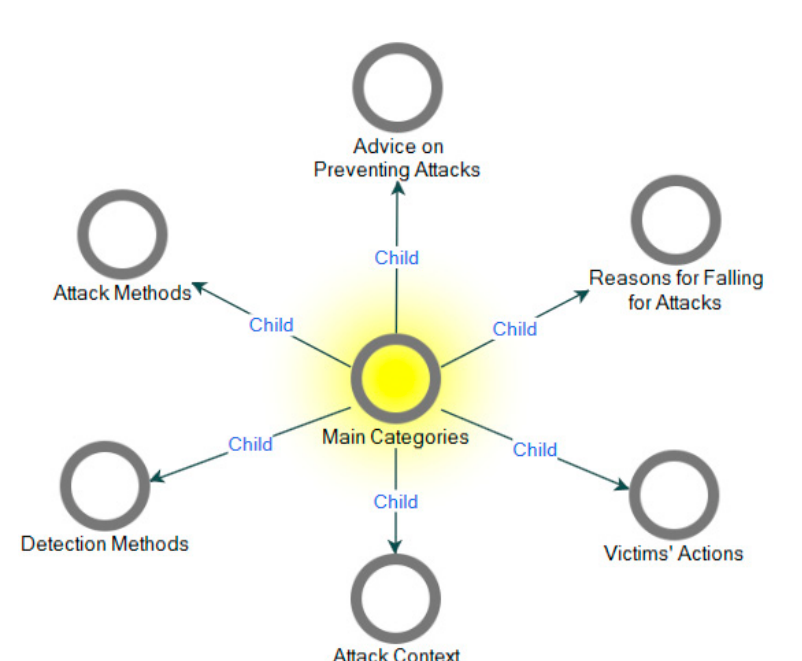
Figure 2. Abstracted 33 categories (free nodes) during open coding.